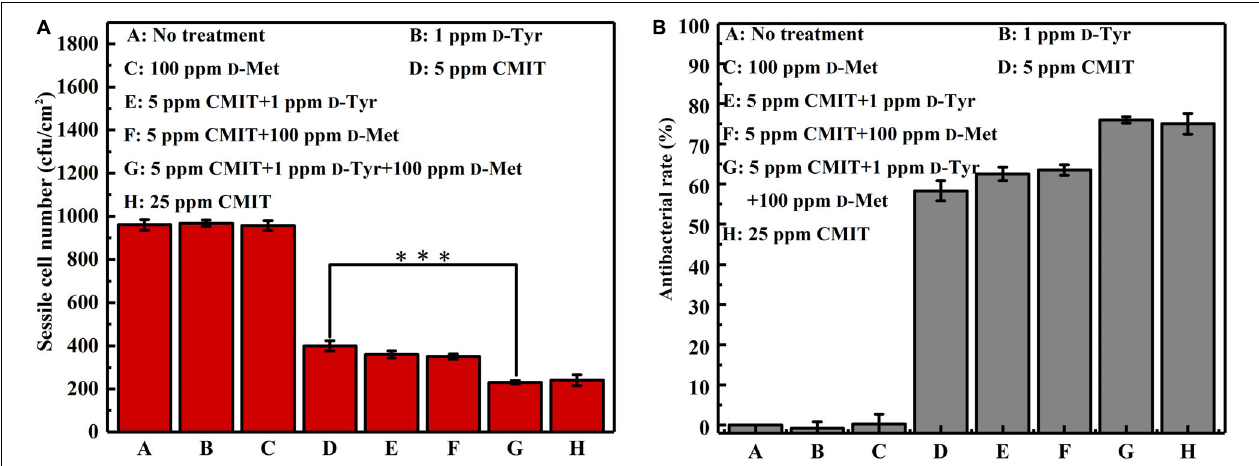
FIGURE 3 | Sessile cell counts after 3-day biofilm prevention test: (A) sessile cell number and (B) antibacterial rate. Standard deviations were from three independent experiments. ∗∗∗ P < 0.001. There was no significant difference between group G and H ( P > 0.05).